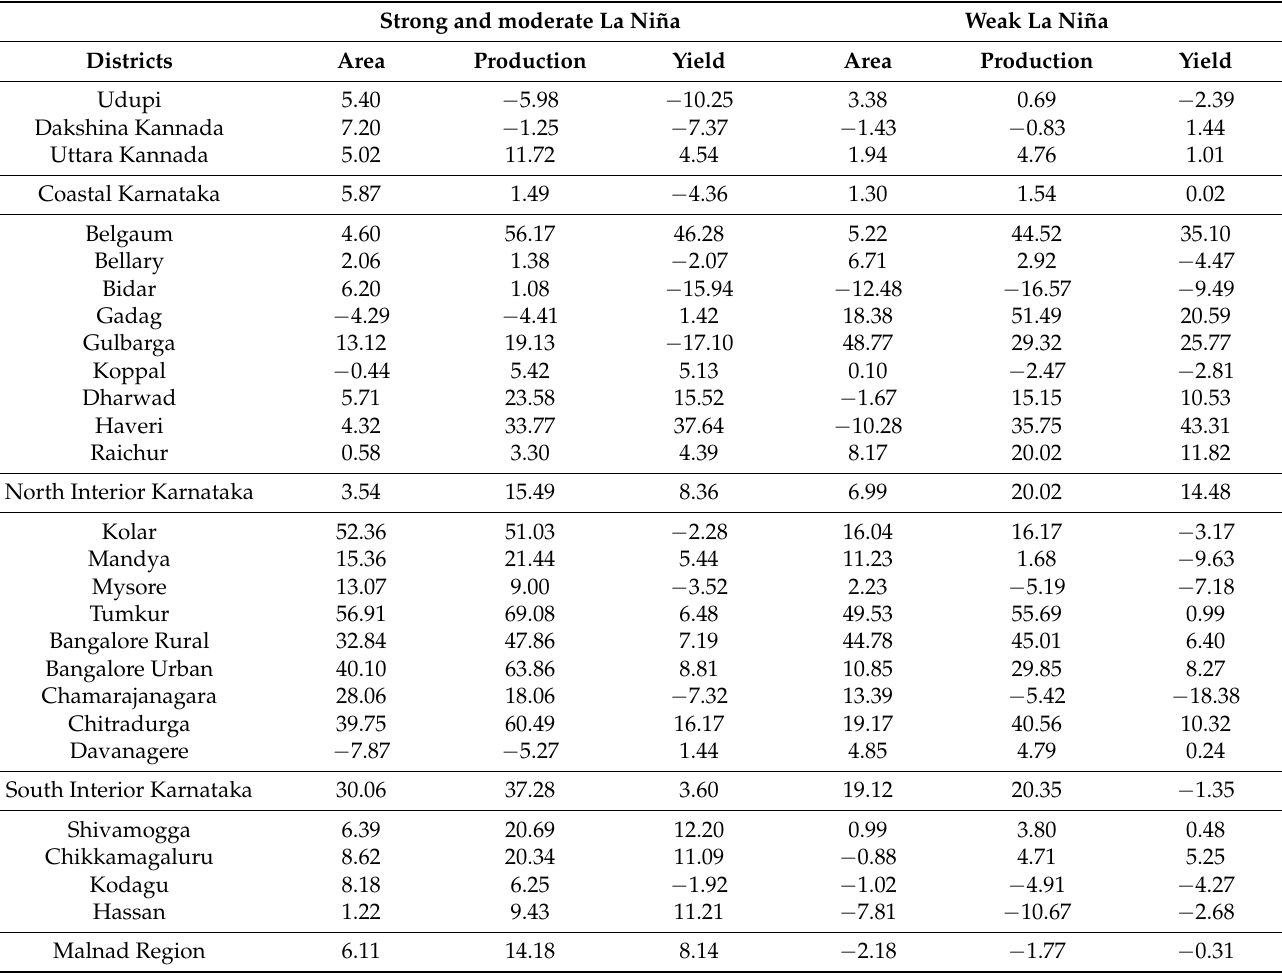
Table 5. District-wise percent change in average area, production, and productivity of Kharif rice during El Niño years compared to normal years